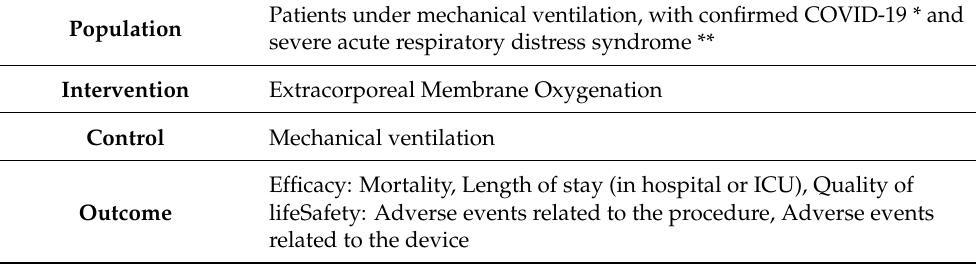
Table 1. PICO question. Patients under mechanical ventilation, with confirmed COVID-19 * and Population severe acute respiratory distress syndrome ** Intervention Extracorporeal Membrane Oxygenation Control Mechanical